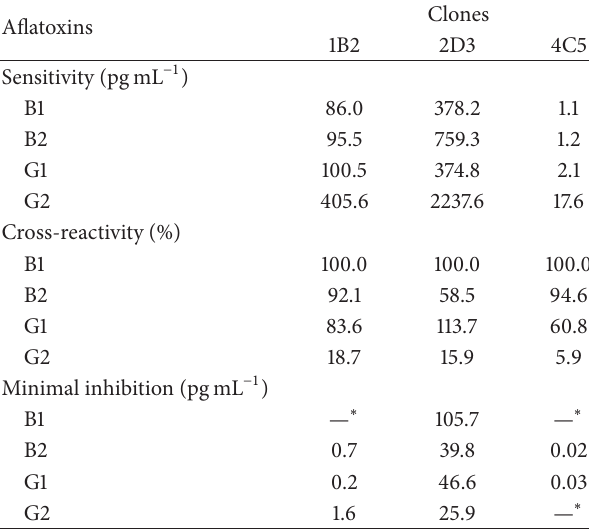
Table 2: Results of sensitivity (expressed as pg mL − 1 ), cross- reactivity (CR%), and the minimal inhibition values of five mon- oclonal antibodies with four major aflatoxins.